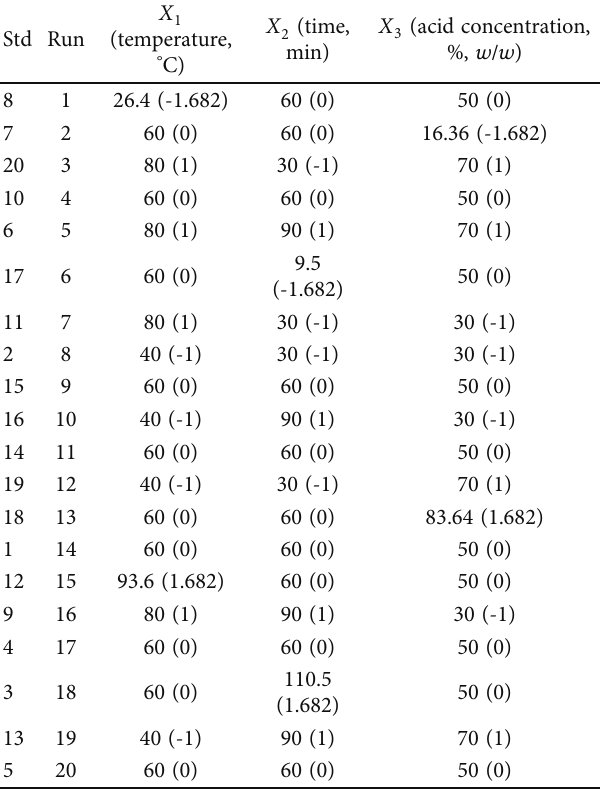
Table 2: Experimental design matrix for the hydrolysis process: actual and coded levels of